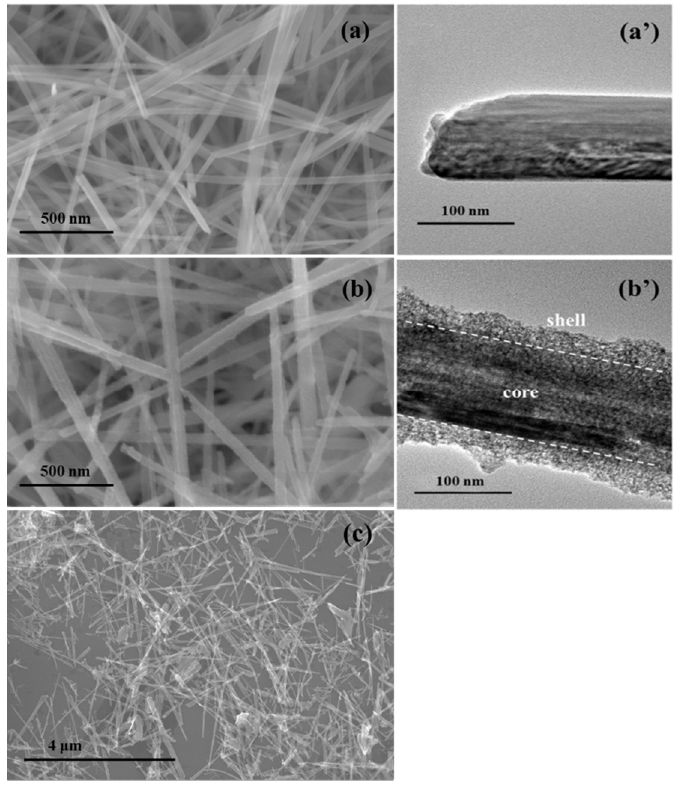
Figure 1. Scanning electron microscopy (SEM), and transmission electron microscopy (TEM) images of ( a ) and ( a’ ) αMnO 2 -NR; ( b ), ( b’ ), and ( c ) αMnO 2 -NR@TiO 2 .